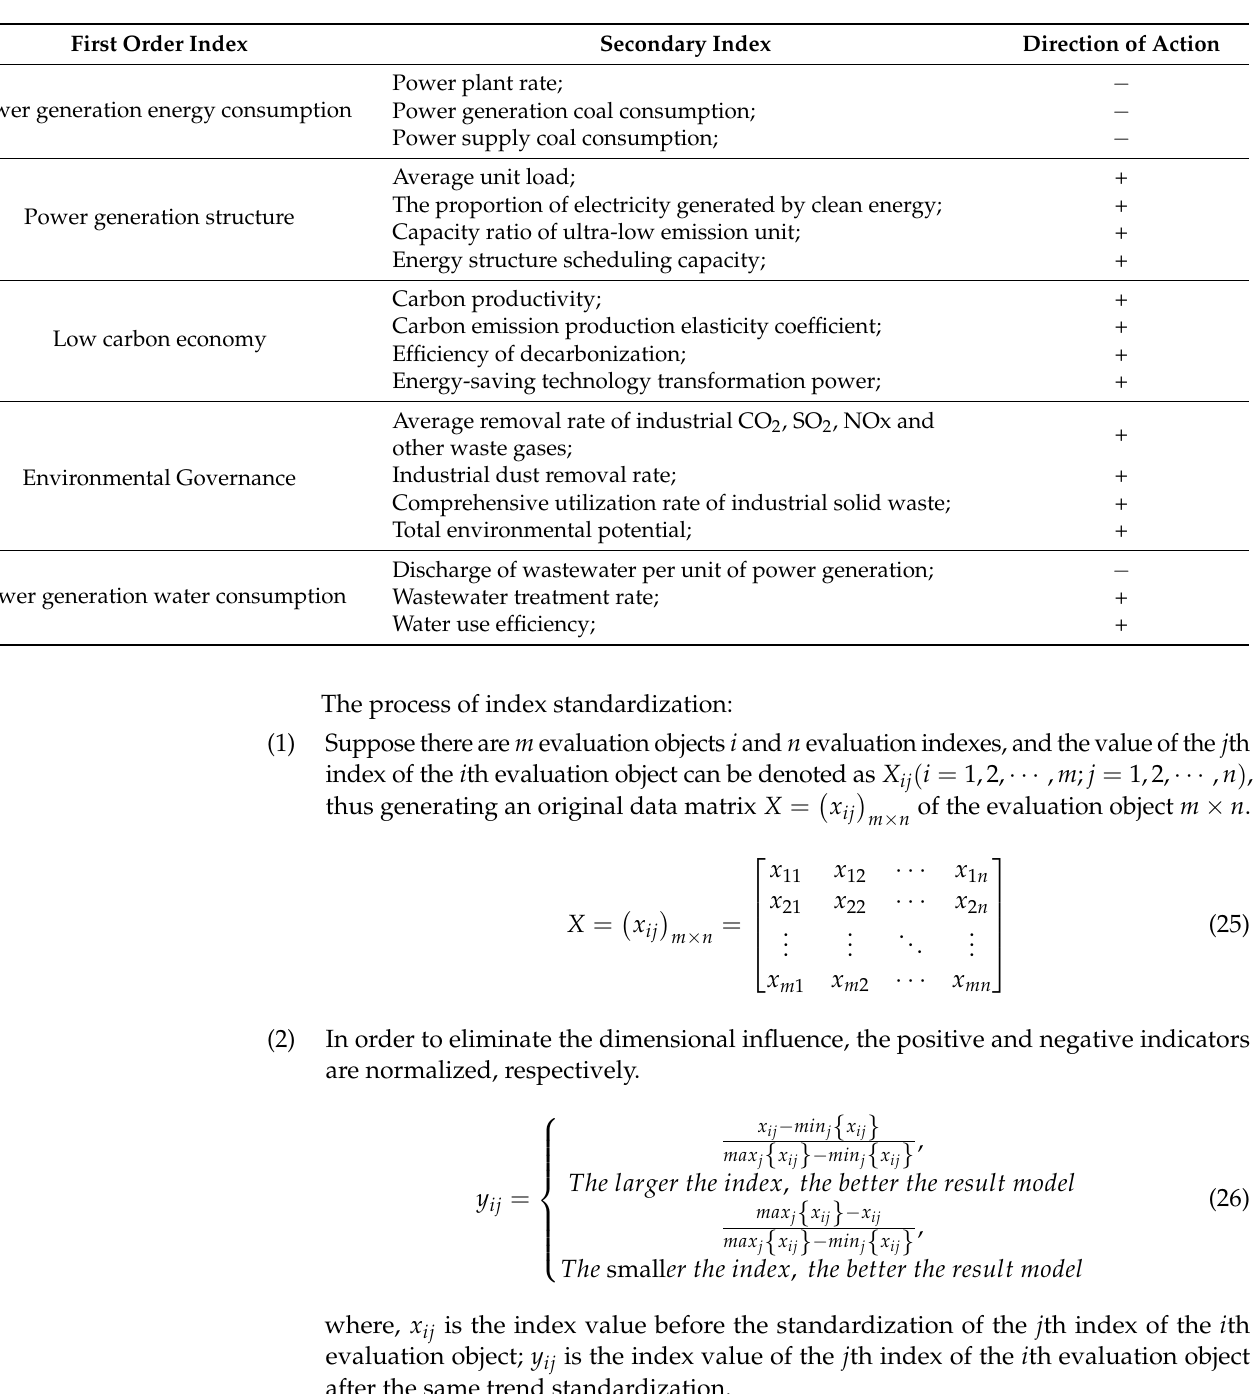
Table 2. Attribute set of comprehensive carbon emission indicators of source coal power